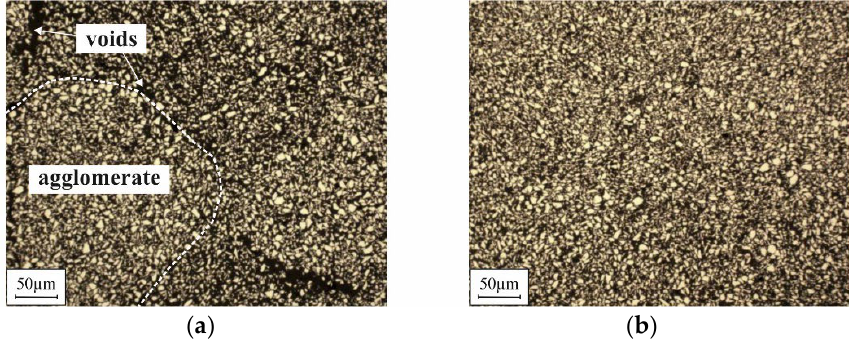
Figure 19. Images of cross-sectional polishes through 3D microstructures fabricated using ( a ) auto- mated filling without compaction and ( b ) automated filling with compaction.